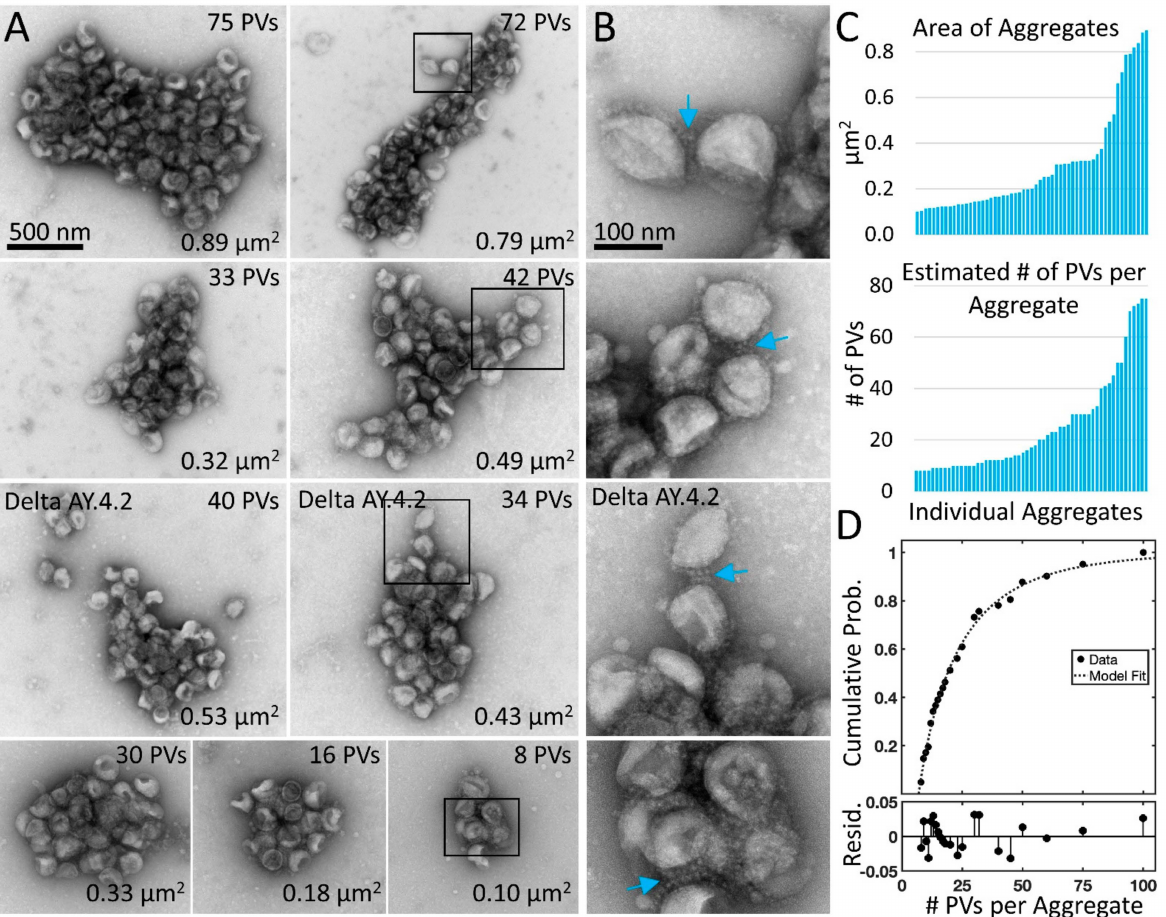
Figure 2. Negative stain TEM of Delta and Delta AY.4.2 aggregates observed 4 h after harvest from producer cells. ( A ) Delta and Delta AY.4.2 PV aggregates representing range of sizes at the 4 h timepoint. The number of PVs estimated per aggregate is indicated in the upper right corner of each image and the area occupied by the aggregate indicated in the lower right corner. Two Delta AY.4.2 PV aggregates are labeled, all others shown are Delta PVs (unlabeled). ( B ) Areas boxed in A are shown enlarged to the right of each image. Blue arrows highlight spike tip interactions occurring between PVs at the periphery of aggregates. ( C ) Graphs show ordered lists of the estimated number of PVs and areas of aggregates. ( D ) Truncated Weibull Distribution for Delta Variant. Negative stain data at 4 h was fit by the general model: f(x) = (wblcdf(x,a,b) − wblcdf(7,a,b))/(1 − wblcdf(7,a,b)) where wblcdf is the Weibull Distribution and x is the PVs per aggregate, 7 is the truncation value, and a and b are the Weibull scale and shape parameters. Coefficients (with 95% confidence bounds) are a = 11.47 (8.35, 14.60) and b = 0.68 (0.57, 0.79). Goodness of fit measure Sum of Squared Error (SSE) = 0.009 and Standard Error of Regression (RMSE) = 0.021, and Resid. are the residuals or differences between the model fit and the